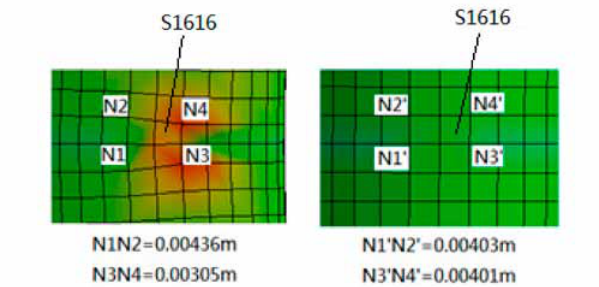
Fig. 12. Error analysis of the element size. Model A is on the left and model B is on the right